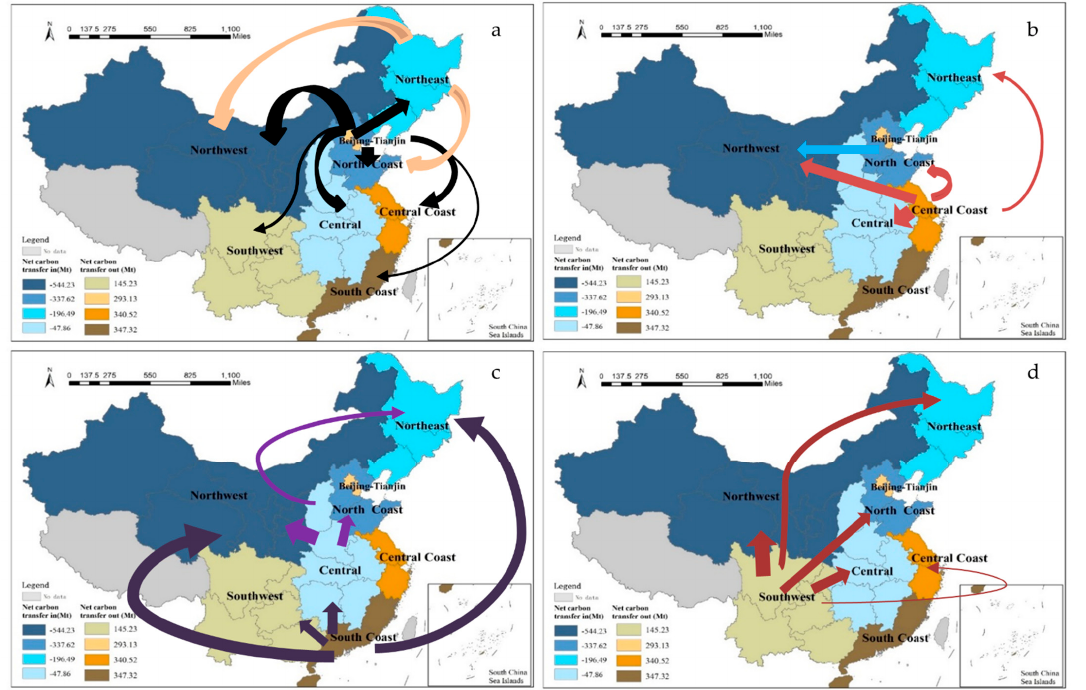
Figure 5. Spatial distribution and steering of net carbon transfer in the eight regions. ( a ) Net carbon transfer out flows from Beijing–Tianjin and the northeast region, ( b ) net carbon transfer out flows from the north coast and central coast regions, ( c ) net carbon transfer out flows from the central and south coast regions, and ( d ) net carbon transfer-out flows from the southwest region.